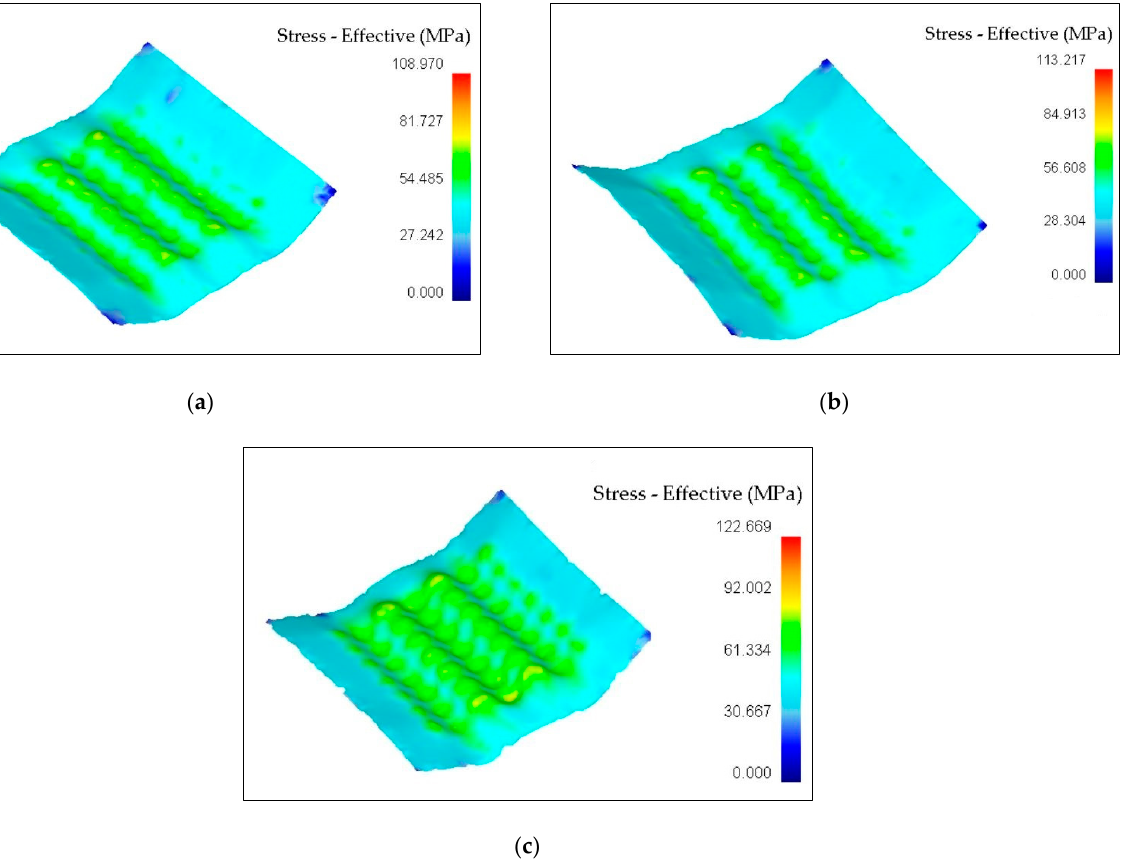
Figure 9. Effective stress distribution of form2 with a pin diameter of ( a ) 10 mm; ( b ) 12 mm; ( c ) 14 mm.